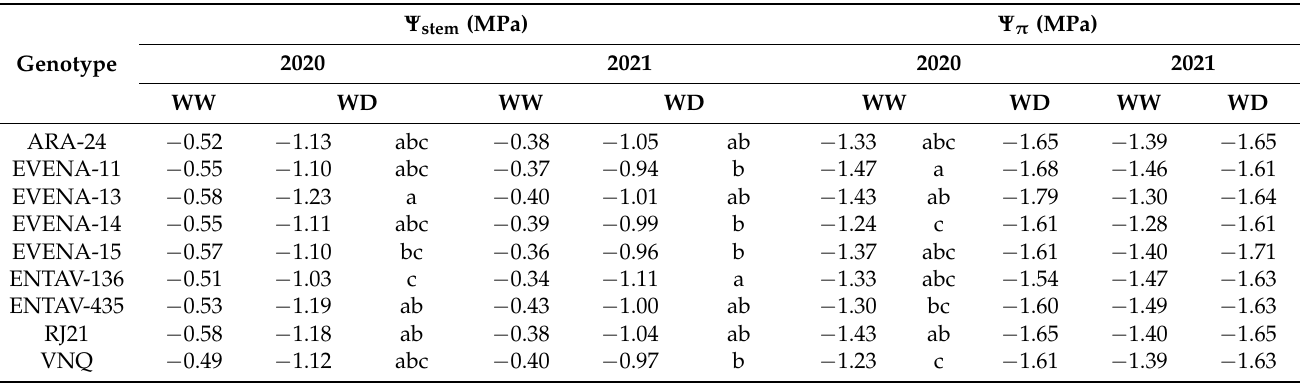
Table 1. Stem water potential ( Ψ stem ) and osmotic potential ( Ψ π ) for each of the 9 “Grenache” genotypes under well-watered (WW) and water deficit (WD) conditions, grown in Mallorca, Balearic Islands, Spain, during 2020 and 2021 seasons.